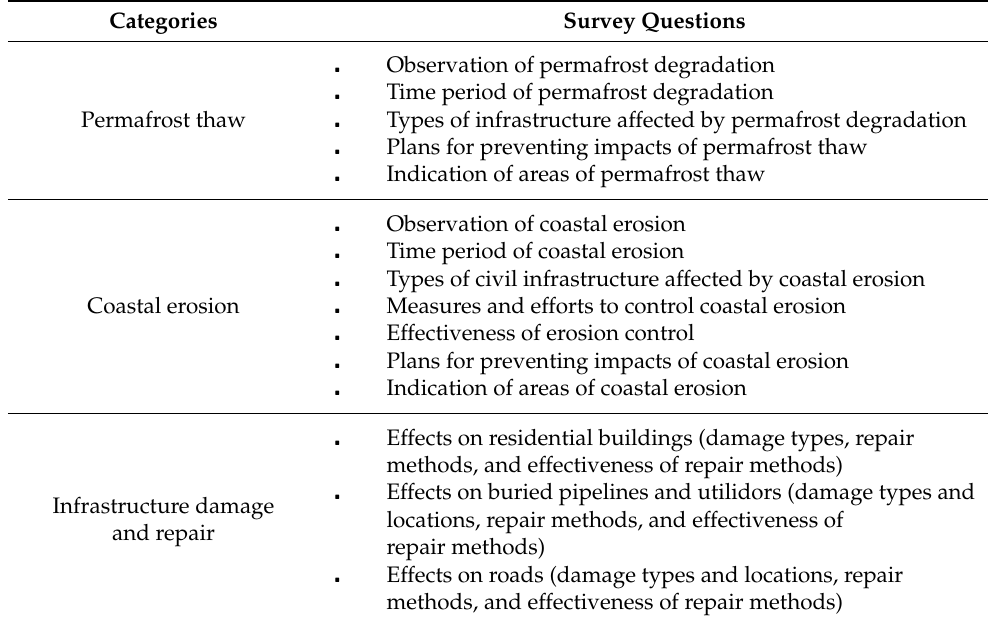
Table 1. Descriptions of survey